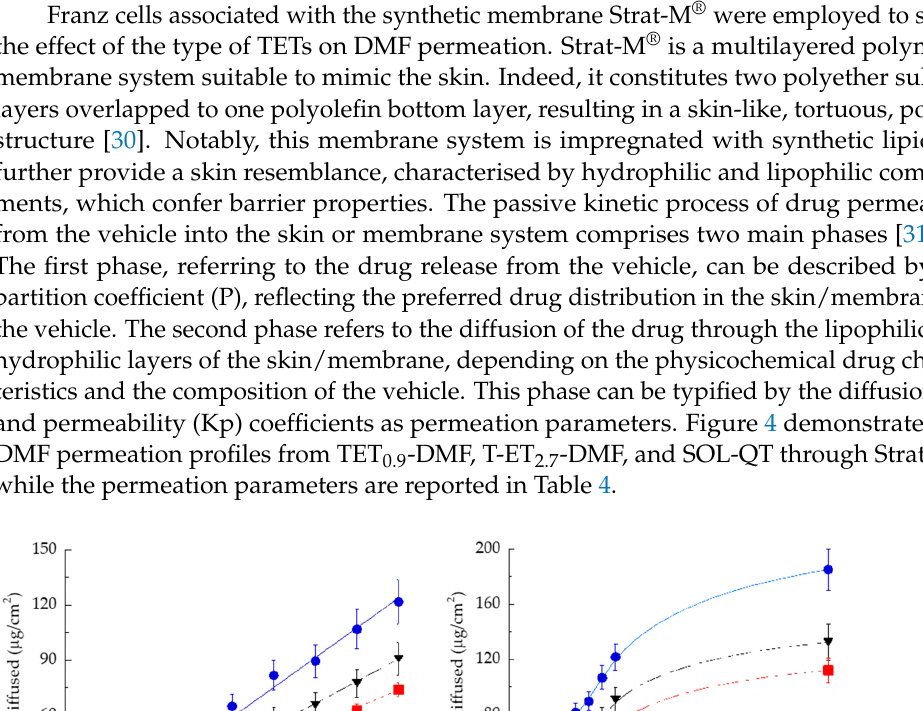
Figure 2. Effect of storage on ethosomes and transethosomes kept at 22 °C for 3 months: ( a ) Z aver- Figure 4. DMF permeability kinetics from TET 0.9 -DMF ( age mean diameters measured via PCS on TET 0 . 9 (o), TET 0 . 9 -DMF ( • ), TET 2 . 7 ( □ ), and TET 2 . 7 -DMF Figure 4. DMF permeability kinetics from TET 0 . 9 -DMF (•), TET 2 . 7 -DMF ( ▪ ), and SOL-DMF ( ▼ ), as ( ▪ ), p values < 0.05; ( b ) DMF residual content in T-ETO 0 . 9 -DMF ( • ), T-ETO 0 . 9 -DMF ( ▪ ) and SOL-DMF determined by Franz cells associated with Strat-M ® . ( a ) linear part of the kinetic profile (0–8 h); ( b ) ( ▼ ). The percentage refers to the total DMF content evaluated after sample preparation; p values < 0–24 h kinetic. Data are the mean of 6 independent experiments ± s.d.